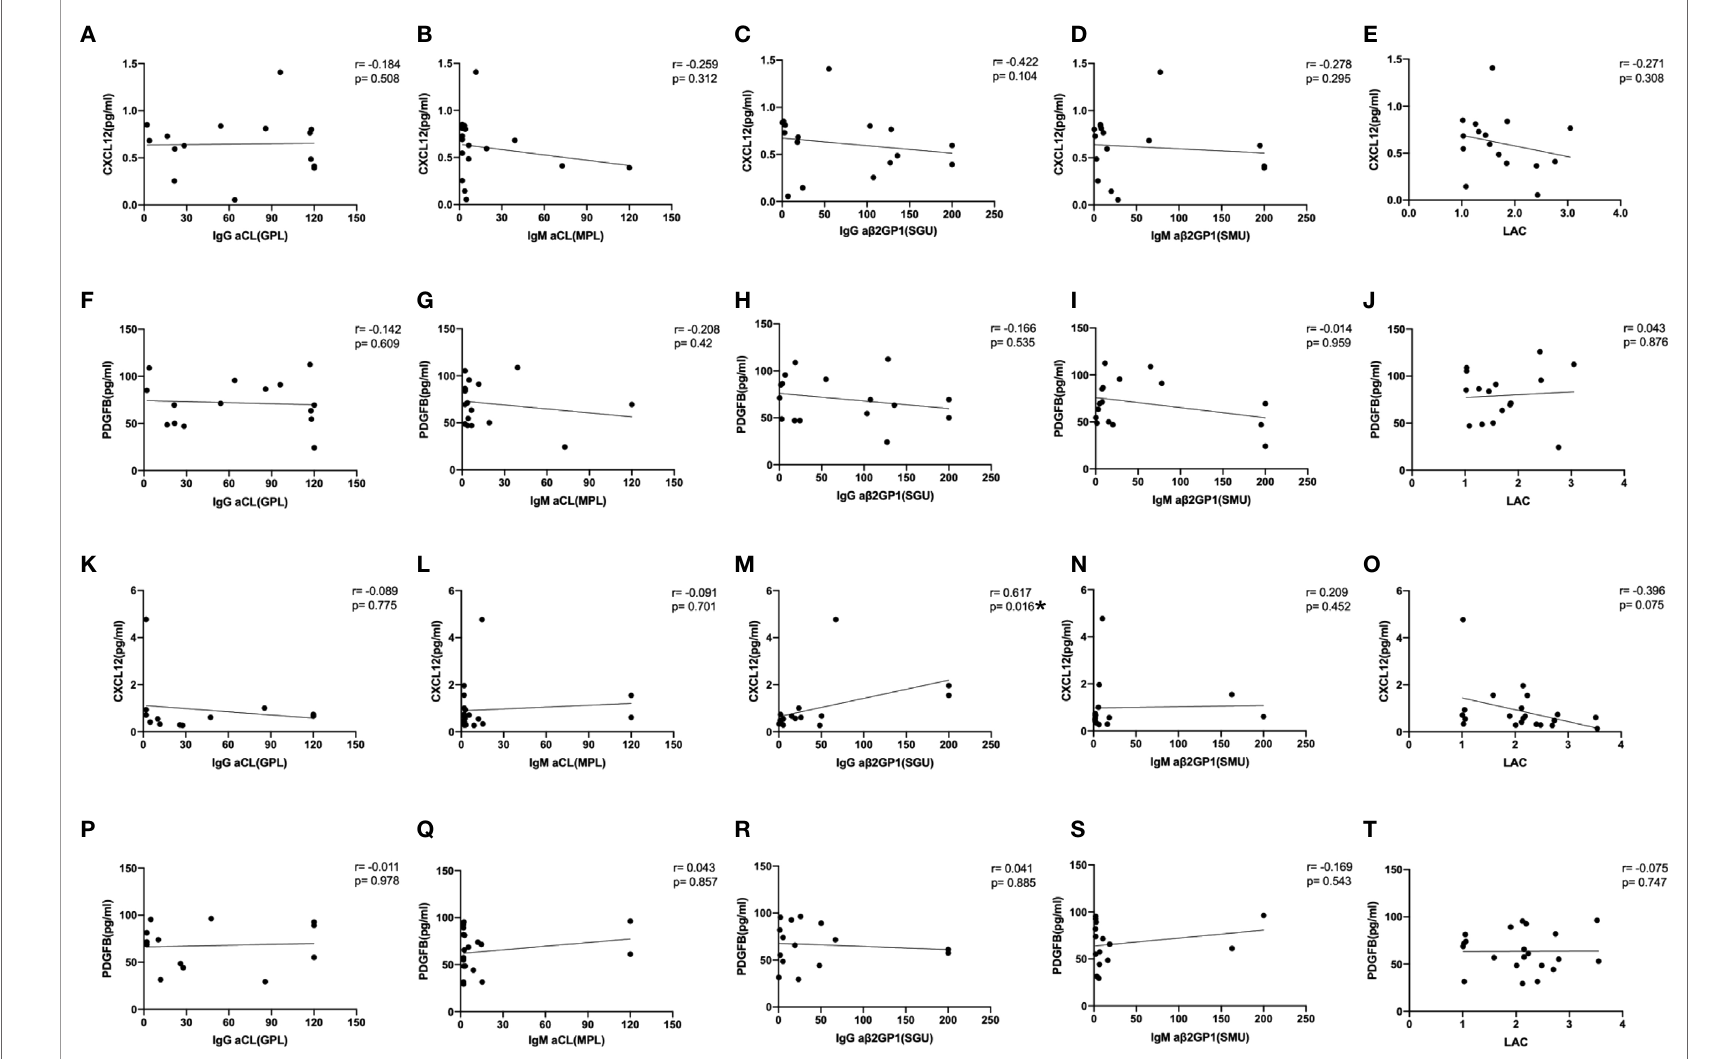
FIGURE 5 | The correlation between the levels of CXCL12, PDGFB with aPLs. The spearman rank-order correlation between the levels of CXCL12, PDGFB and anti-cardiolipin antibody (aCL), anti- b 2-glycoprotein I antibody (a b 2GPI) and lupus anticoagulant (LAC) in OAPS patients (A – J) and TAPS patients (K – T) . * p <